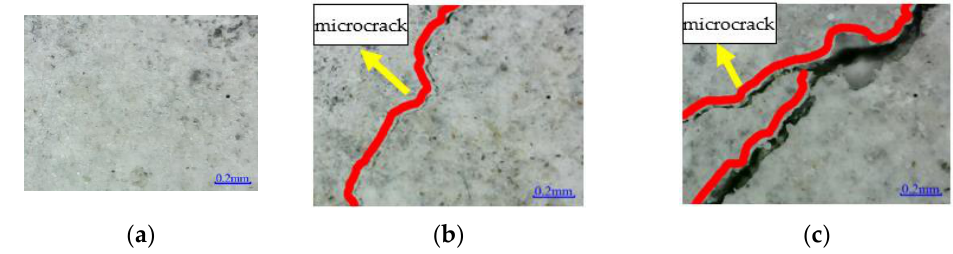
Figure 19. Microstructure of concrete surface: ( a ) RFND; ( b ) RFSI-400; and ( c ) RFSF-100.